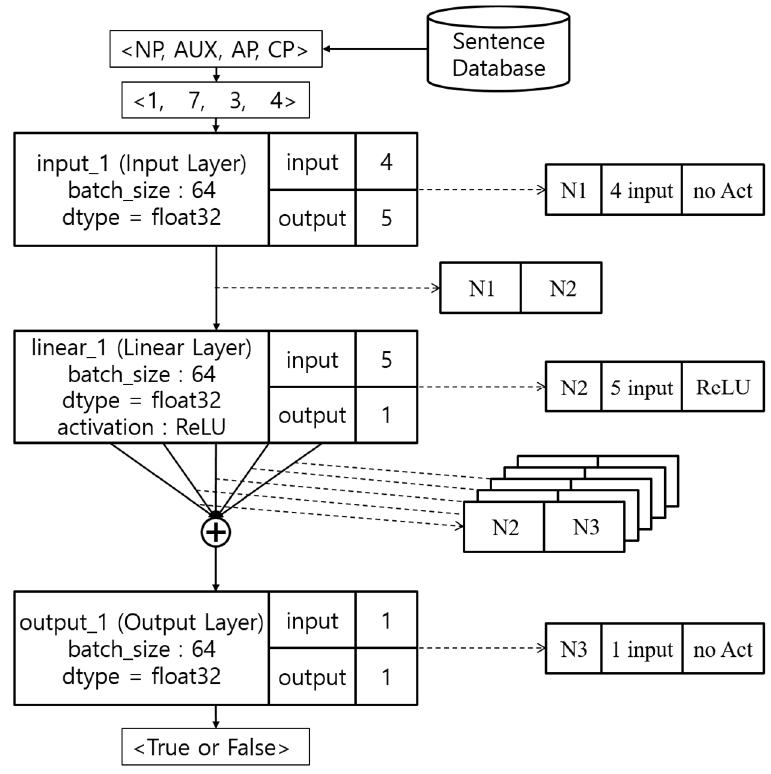
Figure 2. Final structure of Korean grammaticality task.